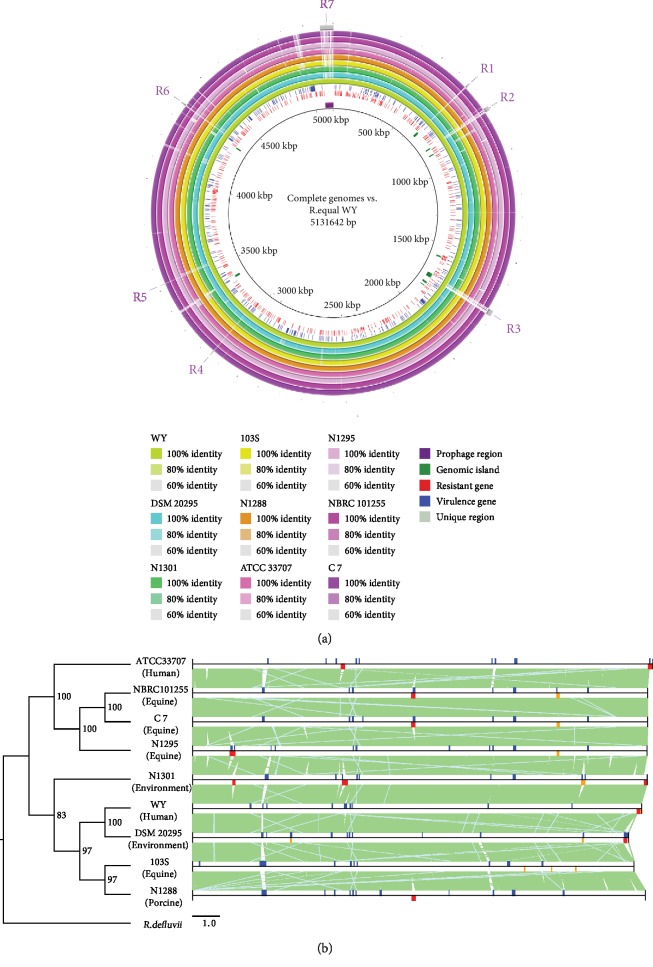
Comparative genomic analysis of nine R. equi strains. (a) The nucleotide sequence of R. equi WY was used as a reference (backbone) and compared with those of eight query genomes. Counting from the outside toward the center: gray color (slot 1) indicated unique regions in R. equi WY, which were labeled R1-R7. Slots 2-10 showed that the corresponding query regions had higher sequence identity (>60%) with the reference sequence. Empty regions on the query slots indicated parts without similar hits between the reference sequence and the query sequences. Labels for slots 2-14 are shown in the legend. (b) Phylogenetic analysis (left) and comparison of genome structure (right) of nine R. equi strains. Phylogenetic reconstruction was based on concatenated SNPs of nine R. equi genomes rooted with R. defluvii. The identical sequence regions are connected by light green bars, while nonidentical regions are left empty. The different functional elements are labeled in different colors, with genomic islands in blue, complete prophage regions in red, and incomplete prophage regions in orange.